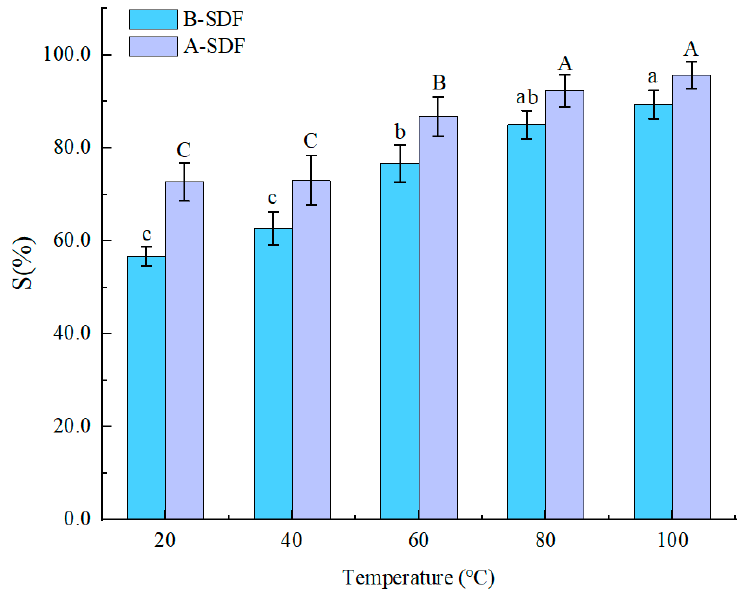
Figure 4. Effect of temperature on solubility of SDF extracted from glutinous rice bran by different methods. B-SDF extracted by the hot water extraction process, and A-SDF extracted by the ultrasound-assisted enzymatic method. Different letters on the top of the column indicate significant differences ( p < 0.05).